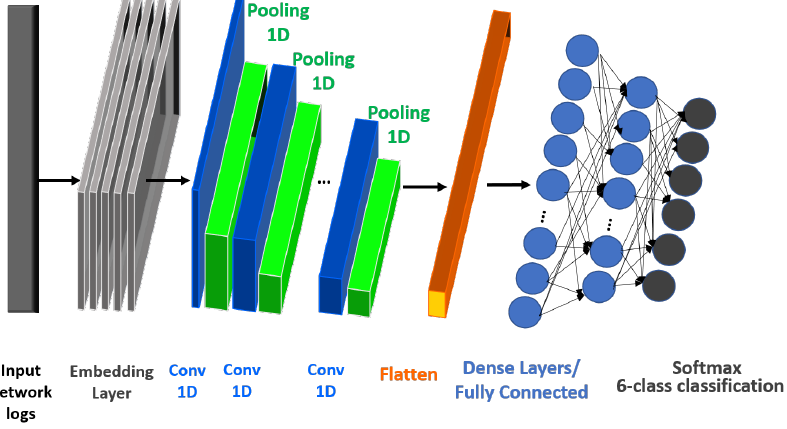
Figure 3. High-level architecture of the proposed multi-class 1D-CNN scheme on Suricata pf- Sense